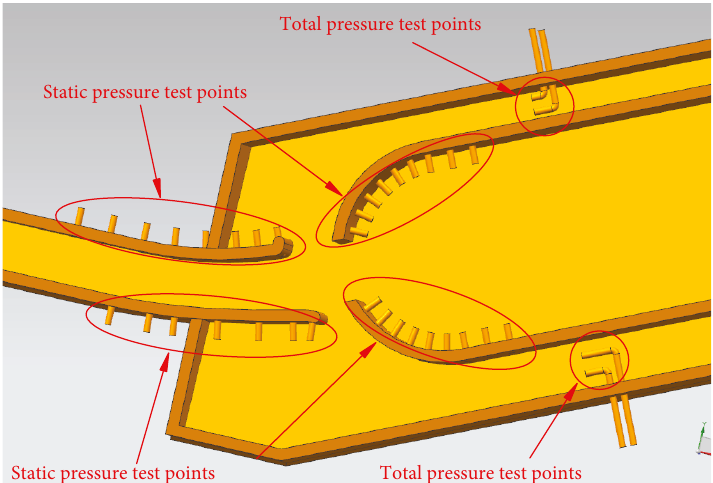
Figure 6: The total and static pressure test points.